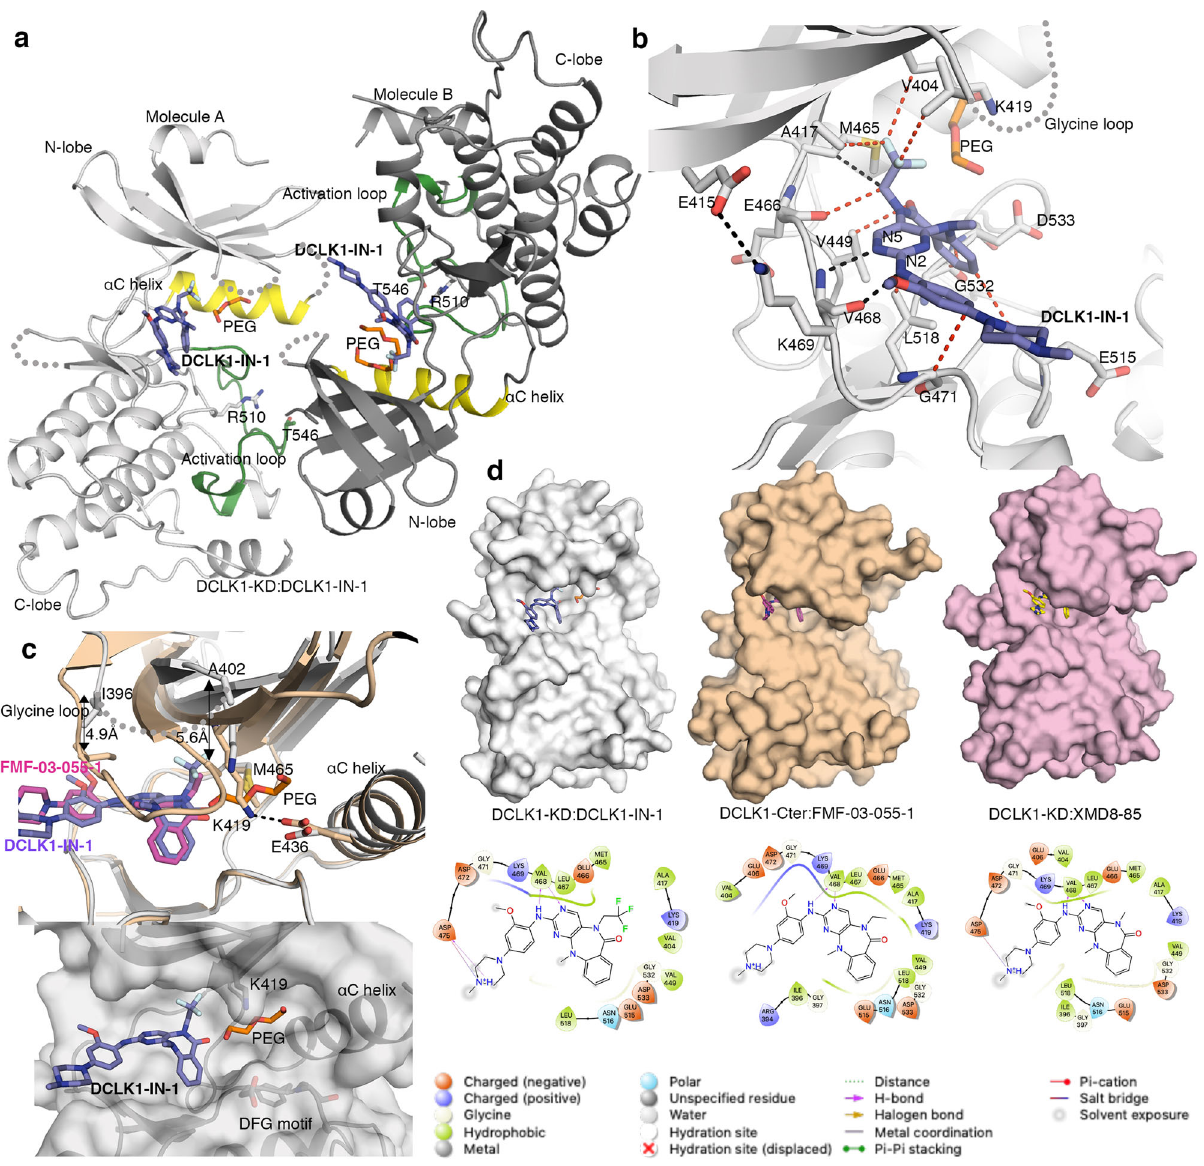
Fig. 4 Structure of DCLK1-KD:DCLK1-IN-1. a The structure of two molecules of DCLK1-KD:DCLK1-IN-1 within the asymmetric unit in a “ head-to-tail ” arrangement. b Close up of the interaction of DCLK1-KD with DCLK1-IN-1. c Overlay of DCLK1-Cter:FMF-03-055-1 with DCLK1-KD:DCLK1-IN-1 to highlight the opening of the ATP binding site and surface representation of DCLK1-KD:DCLK1-IN-1 showing the site occupied by a PEG molecule. The region near the glycine loop undergoes an upward shift (arrows indicated) by 5 Å (distance measured at the C α atom of Ile396 located at the start of the glycine loop and Ala402 located at the end of the loop) to accommodate the bulky tri fl uoroethyl group. d Surface representation of DCLK1-KD:XMD8-85, DCLK1-Cter:FMF- 03-055-1 and DCLK1-KD:DCLK1-IN-1 and ligand interaction diagrams generated using Schrödinger Maestro. The missing residues in DCLK1-KD: DCLK1-IN- 1 are shown in grey dashed lines. The h-bond and van der Waals interaction are shown in black and red dashed lines, respectively. DCLK1-IN-1, purple; FMF-03-055-1, magenta. See also Supplementary Figs. 6 and